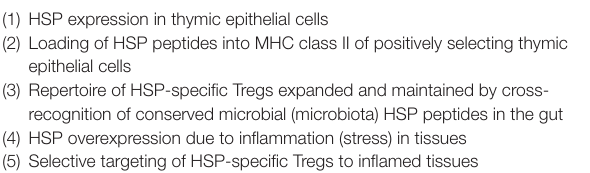
TABLe 1 | Mechanistic sequence of events leading to anti-inflammatory activity of heat shock protein (HSP)-specific regulatory T cell (Tregs). (1) HSP expression in thymic epithelial cells (2) Loading of HSP peptides into MHC class II of positively selecting thymic epithelial cells (3) Repertoire of HSP-specific Tregs expanded and maintained by cross- recognition of conserved microbial (microbiota) HSP peptides in the gut (4) HSP overexpression due to inflammation (stress) in tissues (5) Selective targeting of HSP-specific Tregs to inflamed tissues